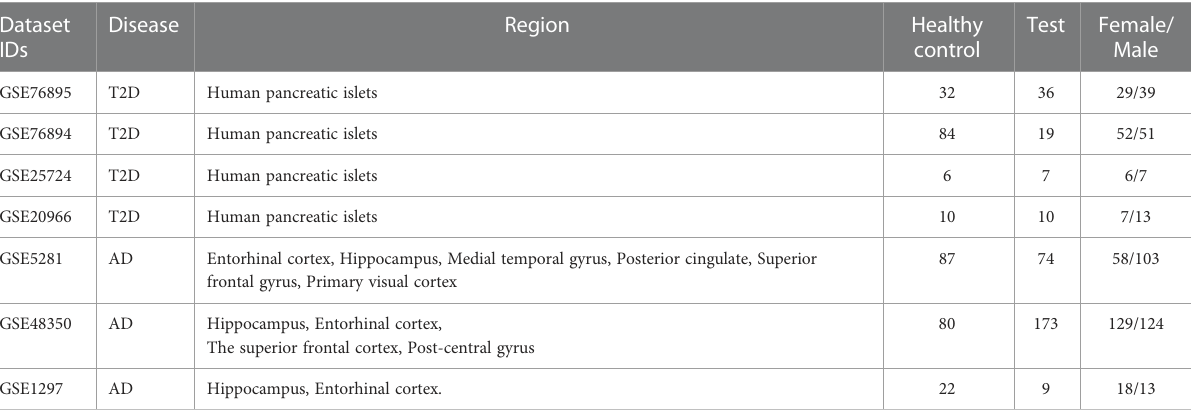
TABLE 1 Description of the GEO gene expression